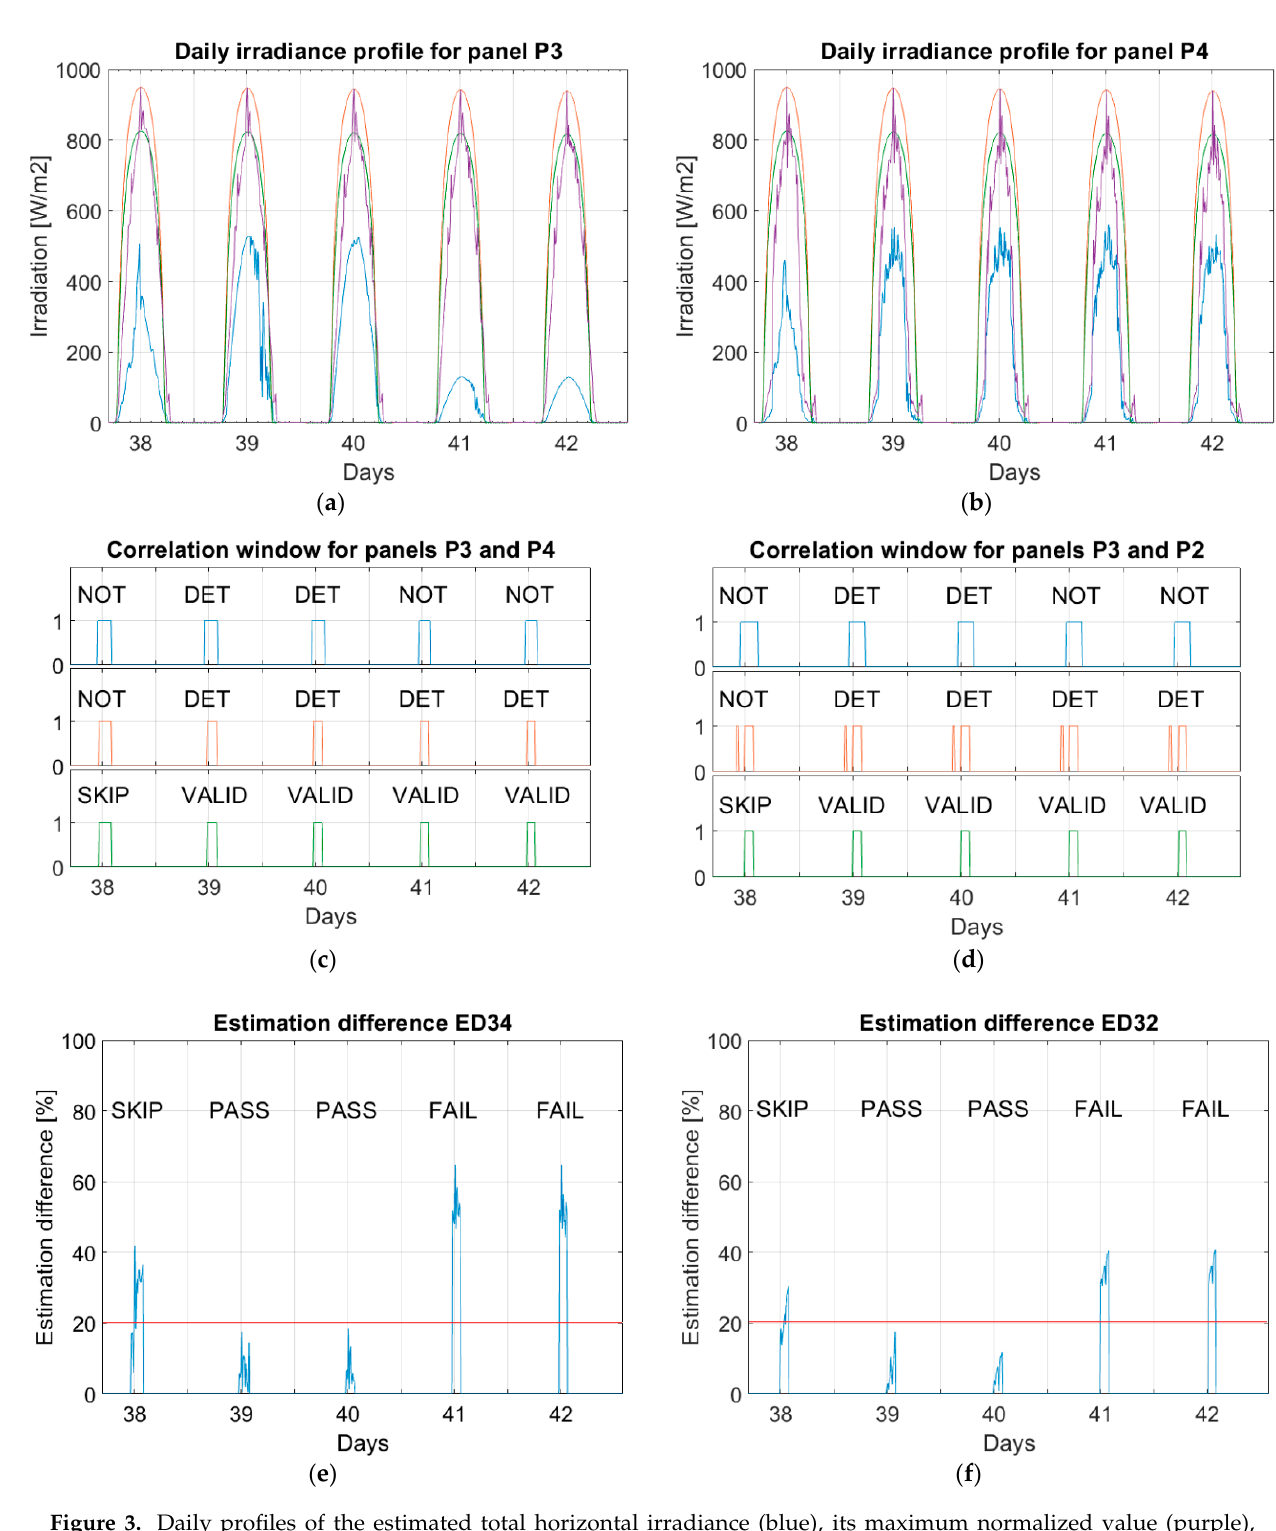
Figure 3. Daily profiles of the estimated total horizontal irradiance (blue), its maximum normalized value (purple), its reference irradiance value (red), and its boundary value for clear-sky conditions (green) for panel 1 ( a ) and panel 2 ( b ); correlation window CW 3 (top), correlation window CW 4 (middle), and cross-correlation window CW 34 (bottom) ( c ); correlation window CW 3 (top), correlation window CW 2 (middle), and cross-correlation window CW 32 (bottom) ( d ); estimation difference factor values ED 34 ( e ); estimation difference factor values ED 32 ( f